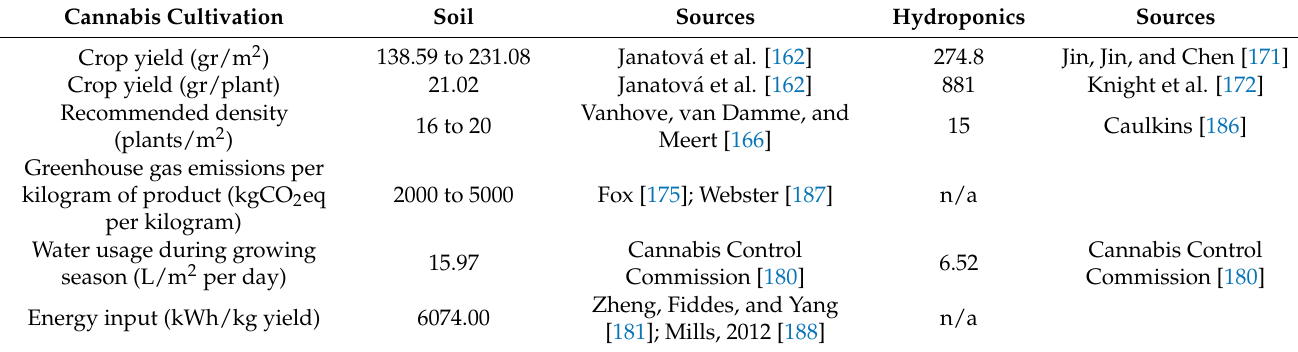
Table 8. Hydroponic and soil cannabis cultivation case